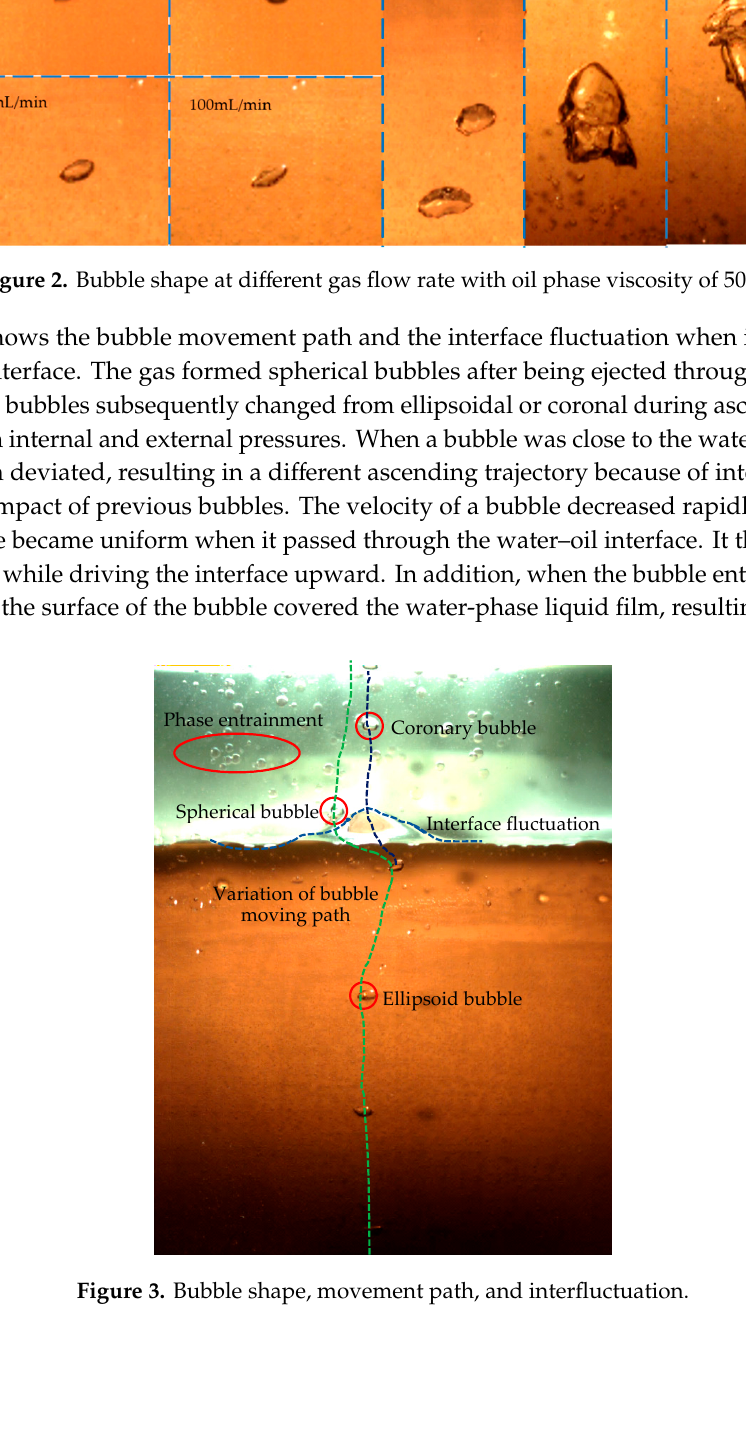
Table 1. Properties of the silicone oils used in the experiments.